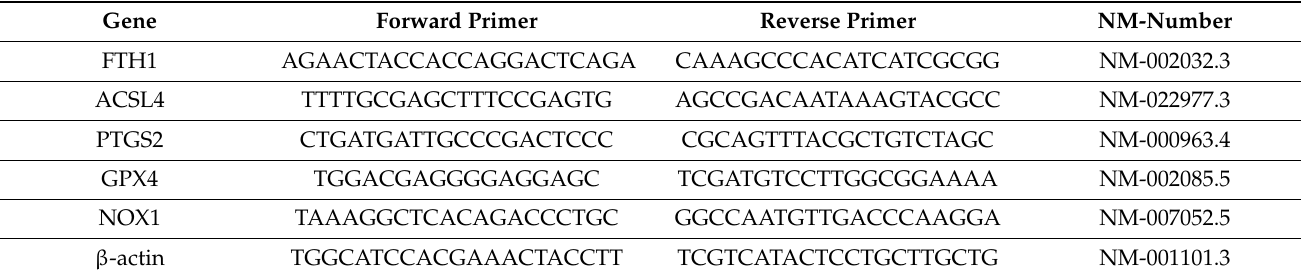
Table 2. Primer Sequences of Ferroptosis-Specific Primers Used in Real-Time